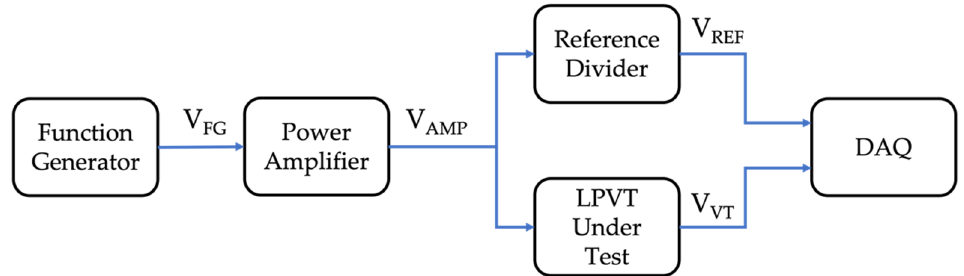
Figure 1. Proposed measurement setup.